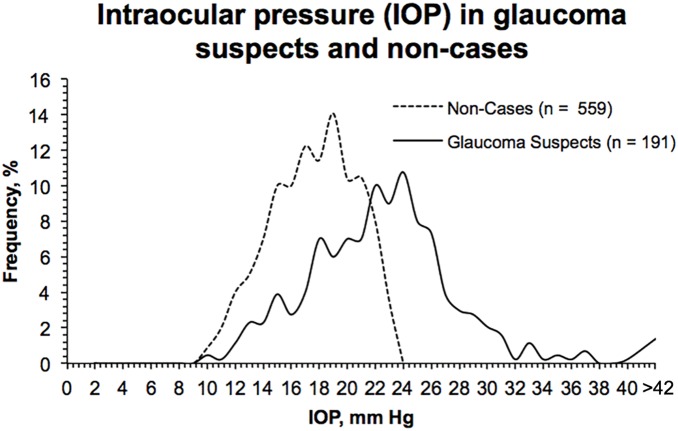
Frequency distribution curves for intraocular pressure in non-cases and glaucoma suspects.